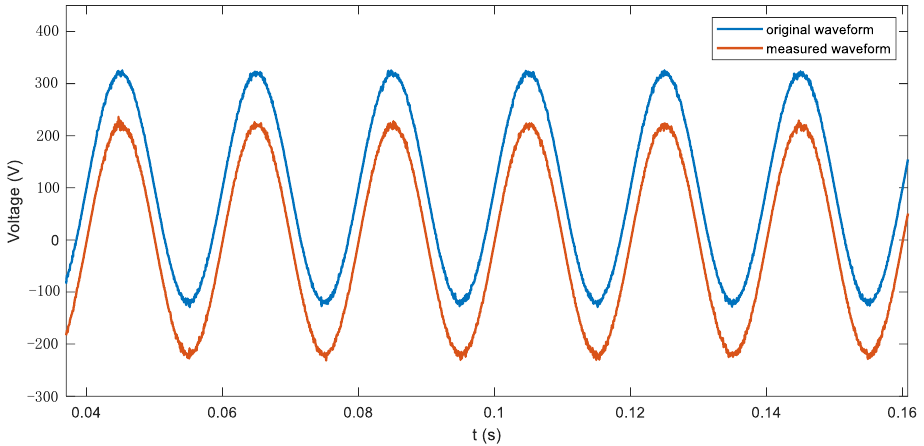
Figure 14. Comparison of original and measured waveforms. Similarly, the linearity of the system was tested using a sinusoidal input signal V X . Ten voltage signals in the range of 80–120% of the rated voltage were selected for measurement according to the voltage calibration standard, and the input raw voltage was measured directly with an Agilent digital multimeter at the same time. The result is shown in Figure 15: